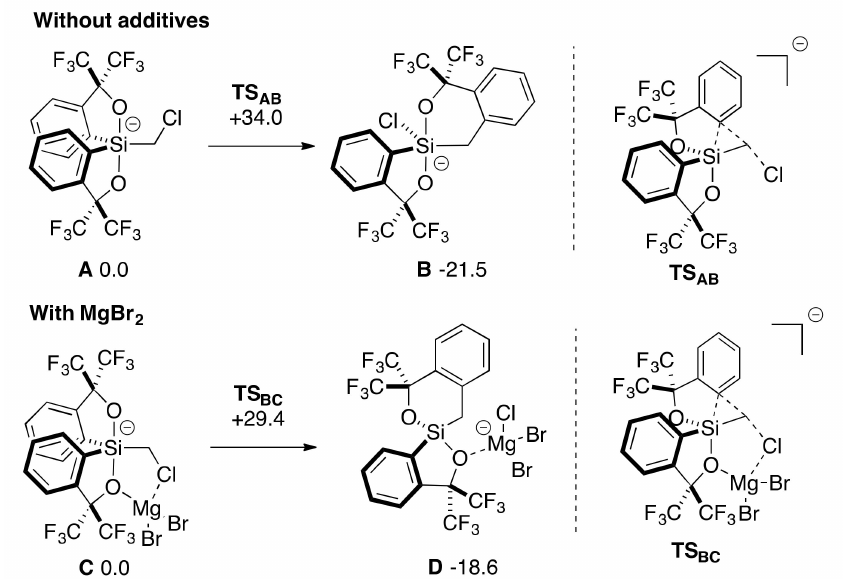
Scheme 4. Gibbs free energy profile for the aryl migration with or without magnesium(II) bromide at the B3LYP-D3/6-311+G(2d,p) level of theory. Energies are in kcal · mol − 1 .